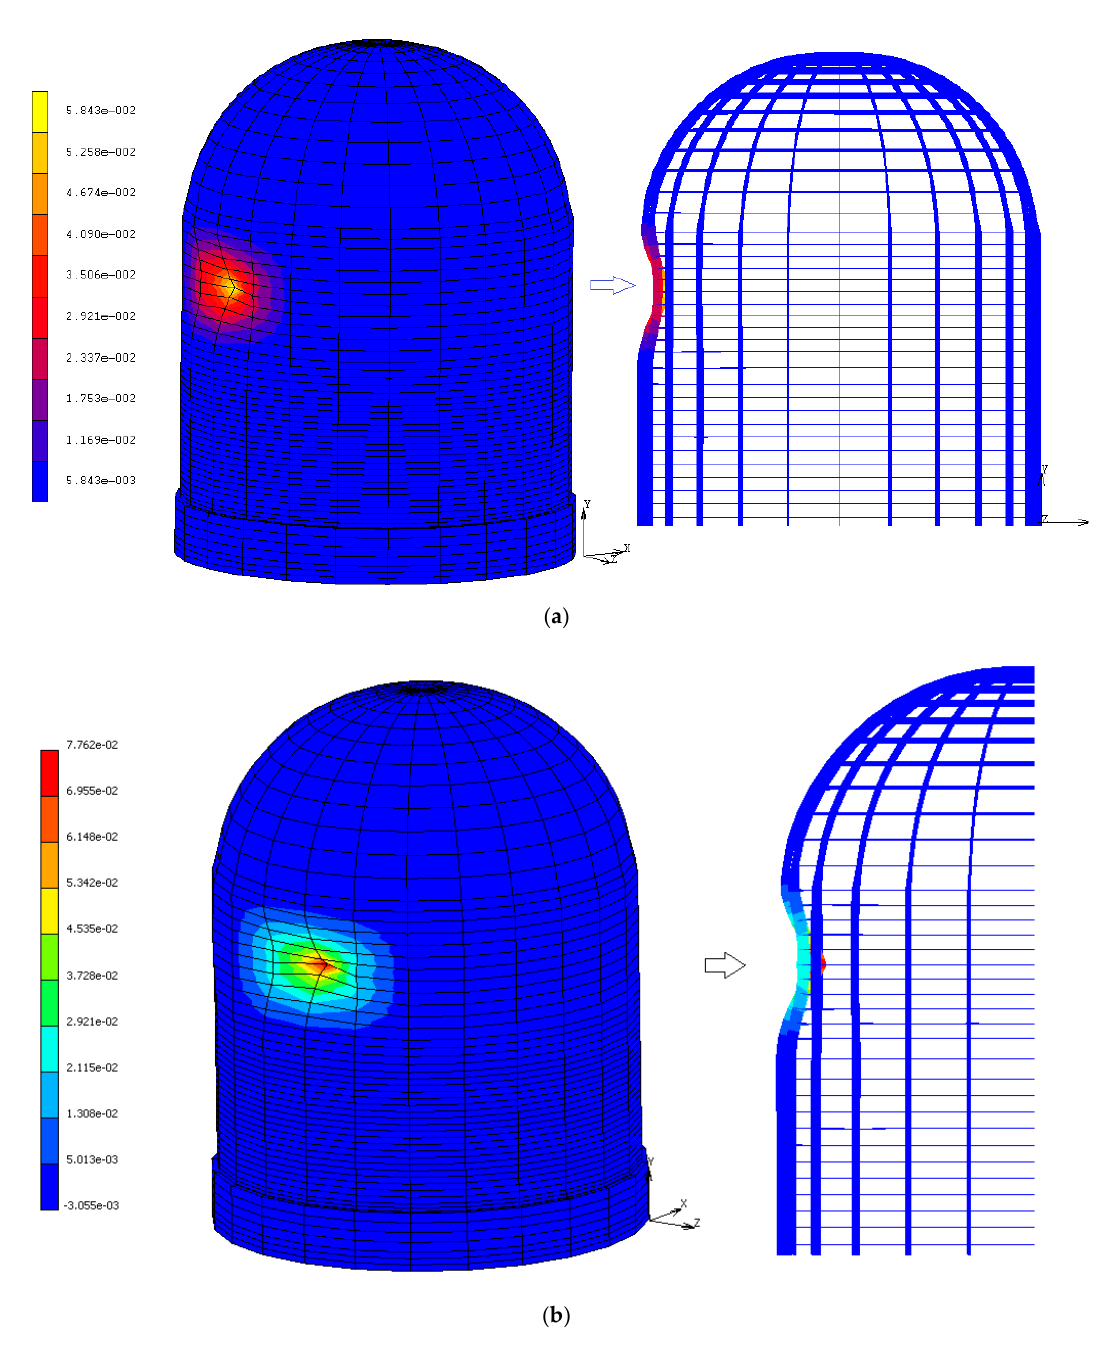
Figure 11. Penetration depth (m) for ( a ) unaged and ( b ) aged CC.